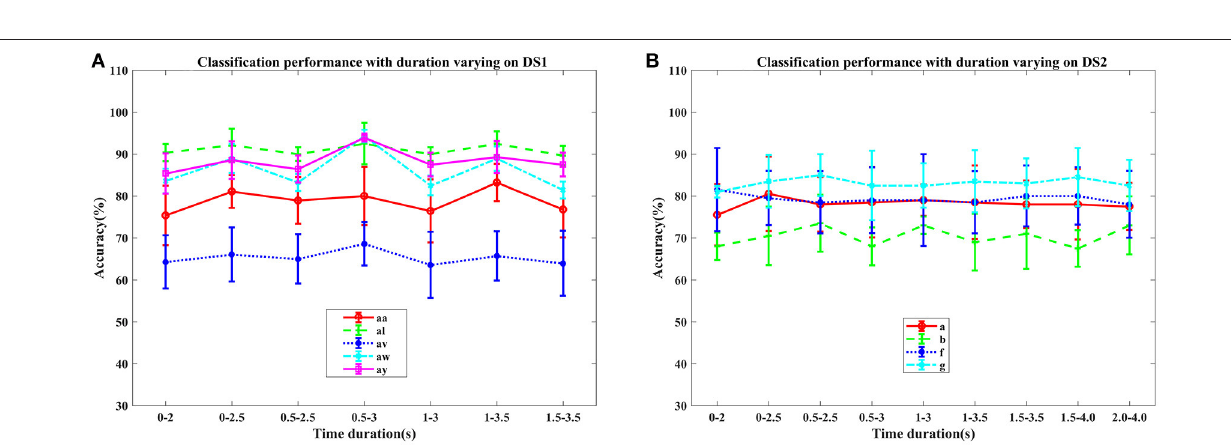
Frontiers in Neuroscience |